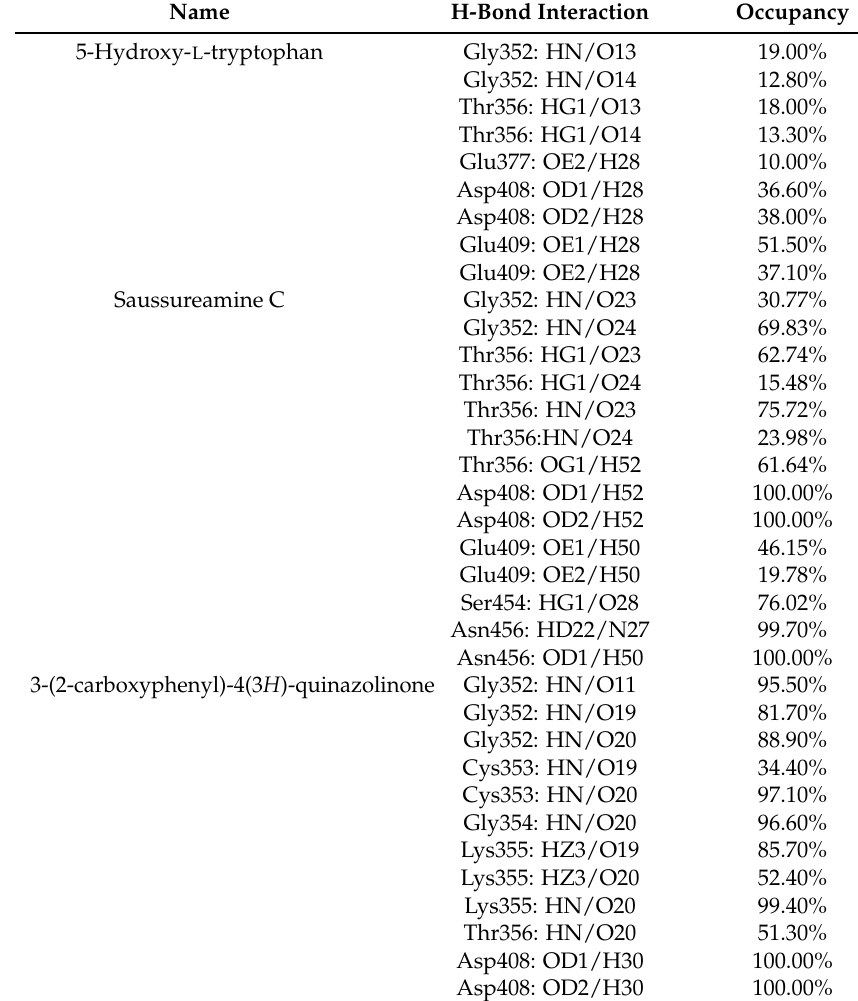
Table 2. Analysis of H-bond occupancies for each ligand during MD